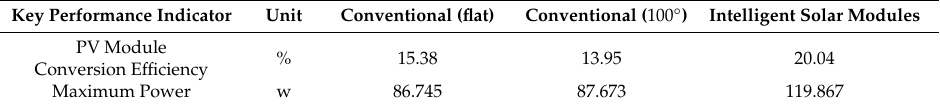
Table 2. Solar module performance measurement results.